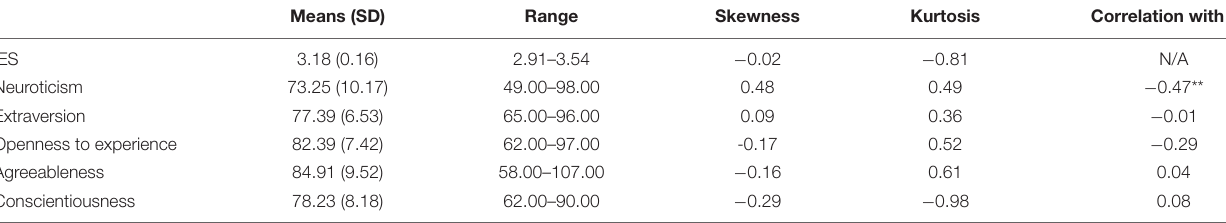
TABLE 1 | Descriptive statistics of dispositional insight (estimated by IES) and each